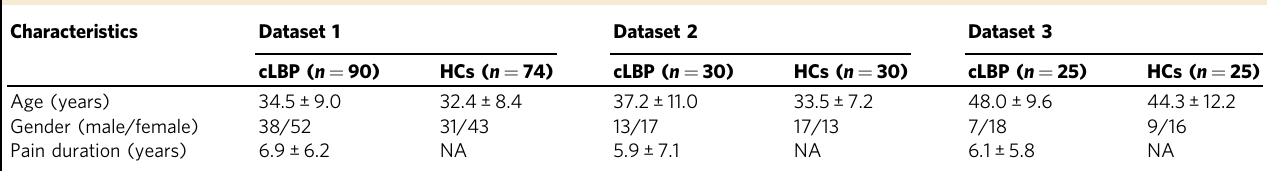
Table 1 Demographics (mean ± SD) of cLBP and